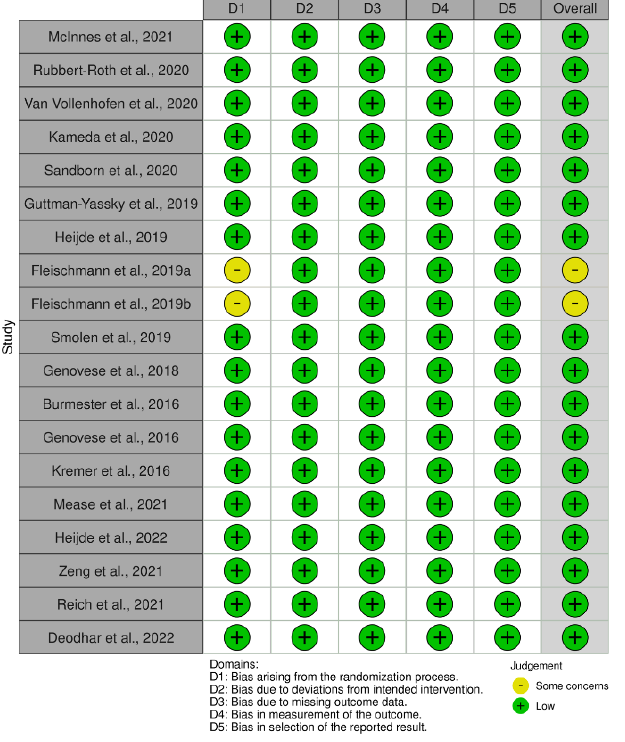
Figure 6. Traffic light plot for risk of bias assessment of the included studies using the revised Cochrane risk-of-bias tool for randomized trials (RoB-2) [8 – 26].